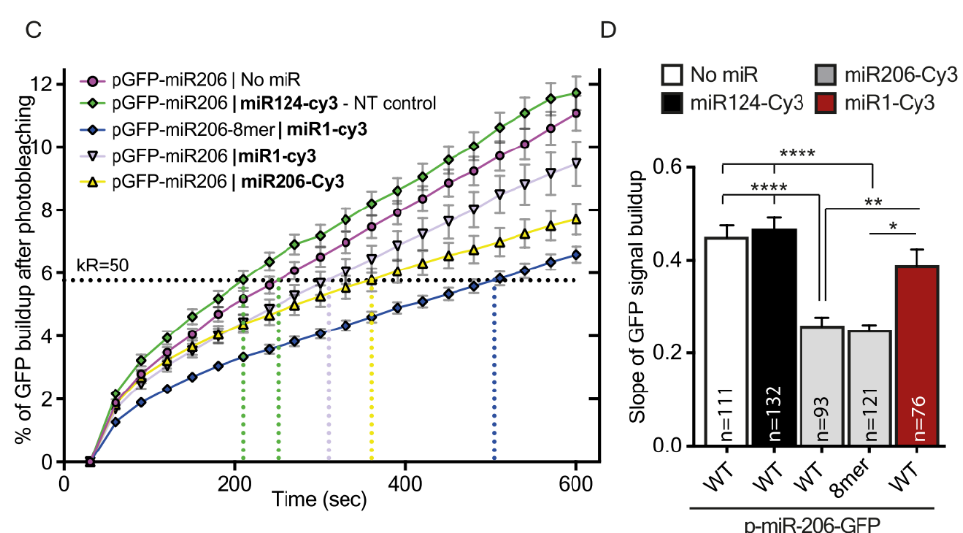
Figure 2. Target GFP downregulation as a function of canonical site variations applies also for miR-206-3p. ( A ) Schematic illustration of the experimental setup. Two dGFP expression plasmids containing miR-206-3p canonical sites in the 3 (cid:48) UTR of dGFP were each co-transfected together with mature Cy3-miR-206 or mature Cy3-miR-1, or mature Cy3-miR-124 as a control, into 293T cells. Green indicates the GFP coding sequence (CDS); light blue indicates the 3 (cid:48) UTR of dGFP; nucleotides labeled in brown indicate nucleotides in full complementation to mature miRNA; nucleotides la- beled in grey indicate random nucleotides not complementing the full sequence of mature miR-1; nucleotides labeled in yellow and red indicate nucleotides in the miRNA target sequence that are complementary and non-complementary, respectively, to the seed sequence; nucleotides labeled in light-green and pink highlight the sequence differences between mature miR-206, miR-124, and miR-1. ( B ) Representative images of dGFP in 293T cells carrying miR-206 canonical sites in 3 (cid:48) UTR. The images show three time points for each cell: 0 min, 5 min, and 10 min after photobleaching. ( C ) The graph shows the cumulative percent of fluorescence of dGFP during the 10 min following photobleaching. The horizontal K R50 line indicates the Y value at which 50% of the maximal recovery is achieved in the non-targeting control. ( D ) Quantification of the mean slope of dGFP recovery after photobleaching. Ordinary one-way ANOVA **** p < 0.0001. Post-hoc multiple comparisons: * p -value < 0.05, ** p -value < 0.01, **** p -value < 0.0001.